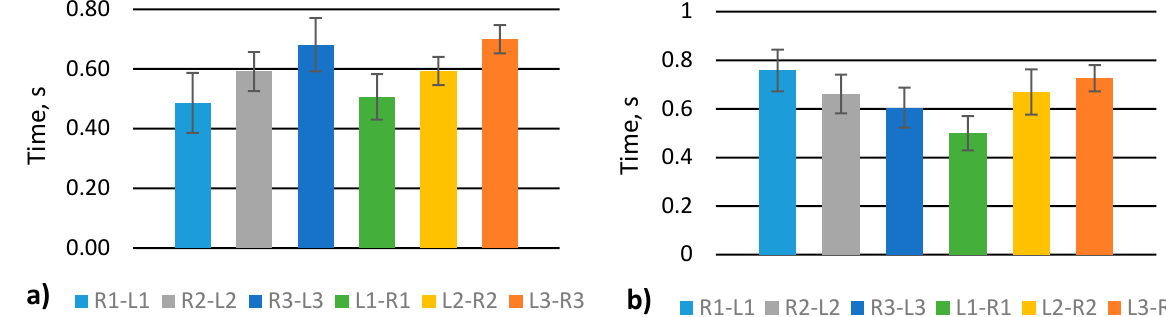
Figure 6. Analysis of stepping abruptness at various gaits: ( a ) scrolling; ( b ) walk with one straight leg. Stepping unevenness was evaluated by extracting L 1–3 –R 1–3 and R 1–3 –L 1–3 parameters (Figure 1c). A scrolling gait shows that the signal increases from 1st to 3rd sensors, i.e., from front to heel, and the signal is similar for the same sensors. For example, R1–L1 is practically the same as L1–R1 (Figure 7a). On the contrary, one straight leg walk shows that the signal decreases from 1st to 3rd sensors for R–L measurement and increase from